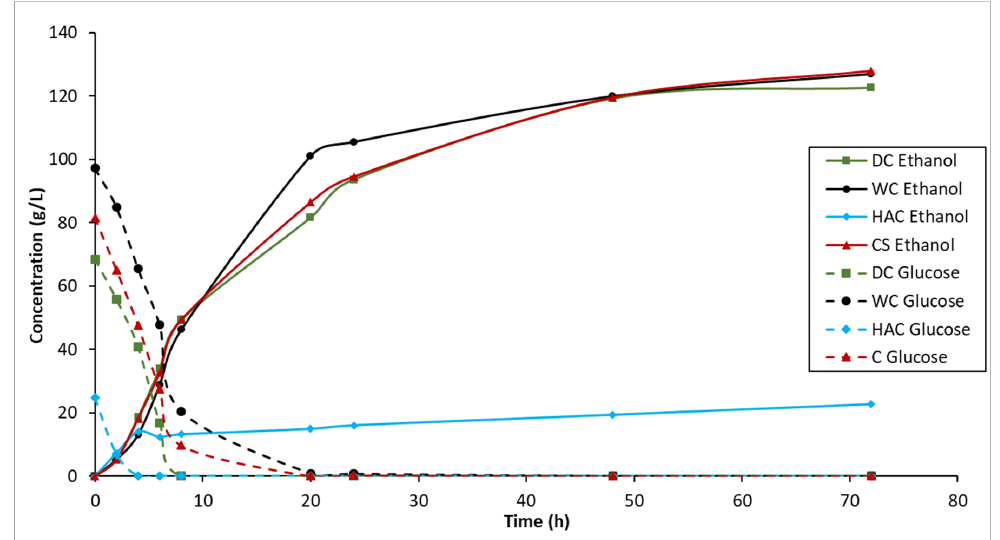
Figure 6. Comparison of ethanol and glucose profiles of dent corn (DC), waxy corn (WC), high amylose corn (HAC), and cassava starch (CS) during granular starch hydrolysis (GSH) fermentation (SSF at 30 °C for 72 h with GSH enzyme and yeast).